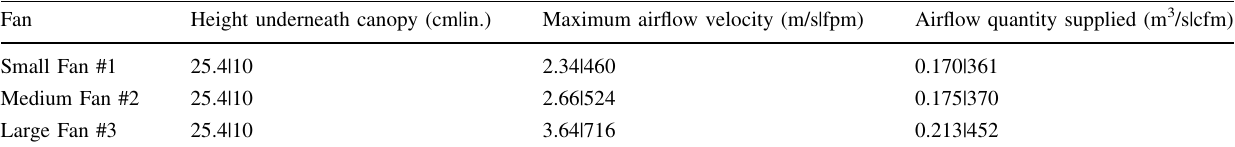
Table 4 Airflow statistics for canopy air curtain Fan Height underneath canopy (cm|in.)